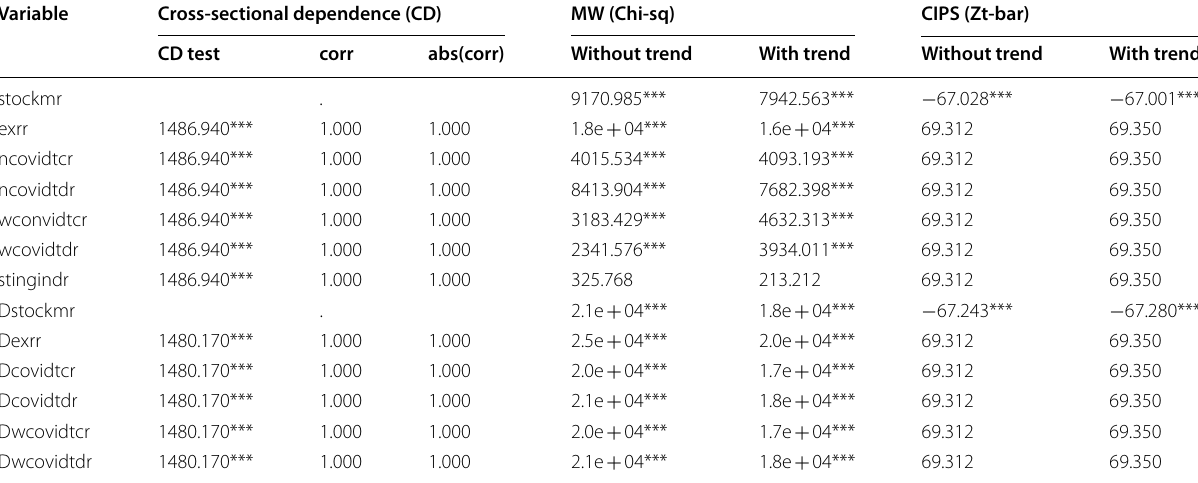
stockmr and exrr represent stock returns and exchange rate returns. covidtcr, and covidtdr stand for growth in domestic COVID-19 cases and deaths. wcovidtcr, wcovidtdr and stinginr represent growth in global COVID-19 cases, deaths and lockdown, respectively. D is the first differences of stock returns, exchange rate returns, growth in both domestic and global COVID-19 cases and deaths. MW and CD tests are the first generation tests with Ho of the cross-sectional independence, whereas the second-generation unit root test—CIPS was carried out with the Ho in which the series are I(1). ***signifies1% level of statistical significance. ***, **, and * denote 1%. 5% and 10% level of significant, respectively